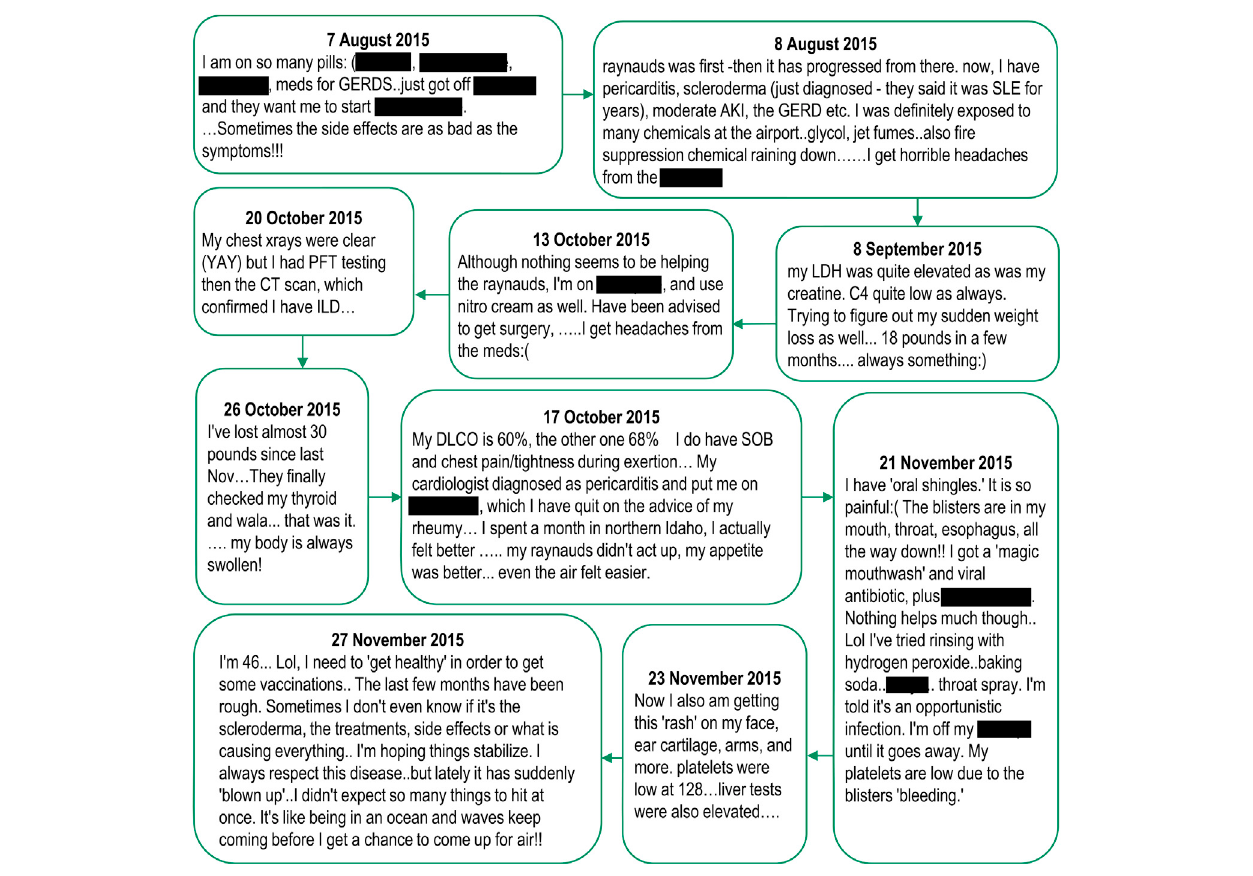
FIGURE6| Relevantmedicalandadverseeventinsightsfromspontaneouslyreportedadverseeventsinsocialmedia,postedbyasingleindividual.Note:Postsare listed verbatim but mentions of drug names have been redacted.